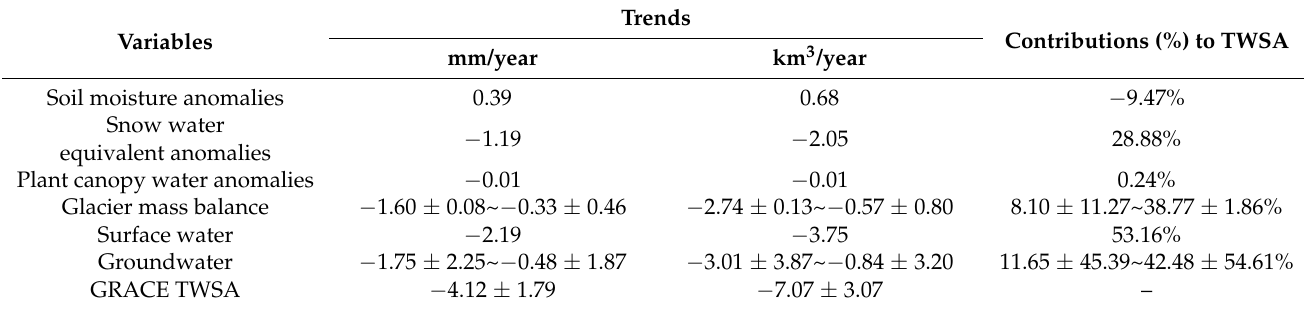
Table 5. Trends in soil moisture, snow water equivalent, plant canopy water, glacier mass balance, surface water, and groundwater, and their contributions to GRACE TWSA during